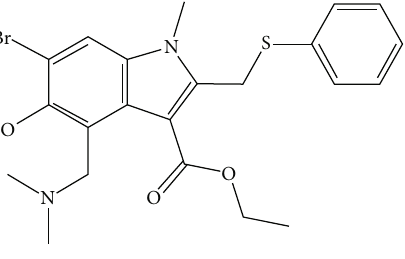
Figure 12: Molecular graph of arbidol. ffiffiffiffiffiffiffiffiffiffiffiffiffiffi p ffiffiffiffiffiffiffiffiffiffiffiffiffiffi 4 2 + 4 2 p ffiffiffiffiffiffiffiffiffiffiffiffiffiffi ffiffiffiffiffiffiffiffiffiffiffiffiffiffi 5 2 + 5 2 ffiffiffiffiffiffiffiffiffiffiffiffiffiffi p ffiffiffiffiffiffiffiffiffiffiffiffiffiffi 6 2 + 6 2